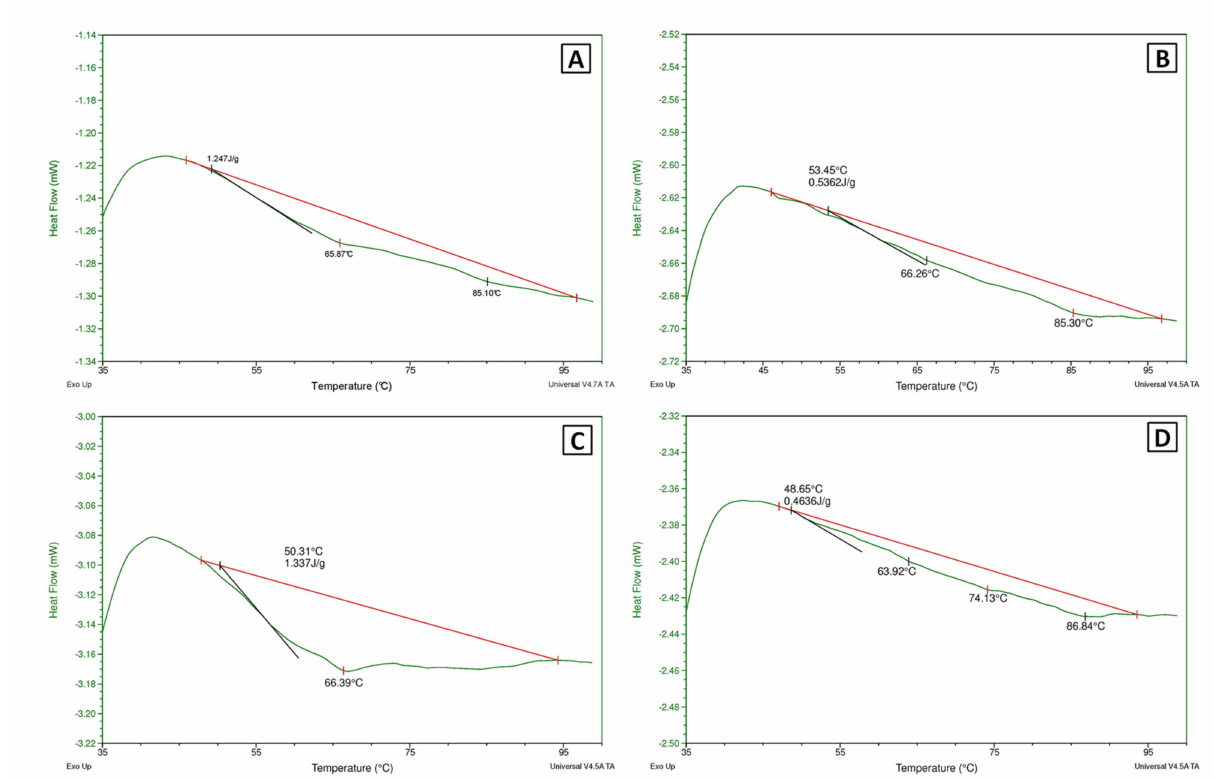
Figure 2. DSC thermograms of porcine liver samples dried at 40 ◦ C ( A ) and 70 ◦ C ( B ), and subse- quently defatted ( C , D ) for samples dried at 40 and 70 ◦ C, respectively, and reconstituted at 19.2% protein ( w / v ), as raw porcine liver. Endothermic heat flow (green lines); initial temperature (Tin) at which heat flow is detected (black lines), and baseline (red lines) for calculating the total Enthalpy of denaturation ( ∆